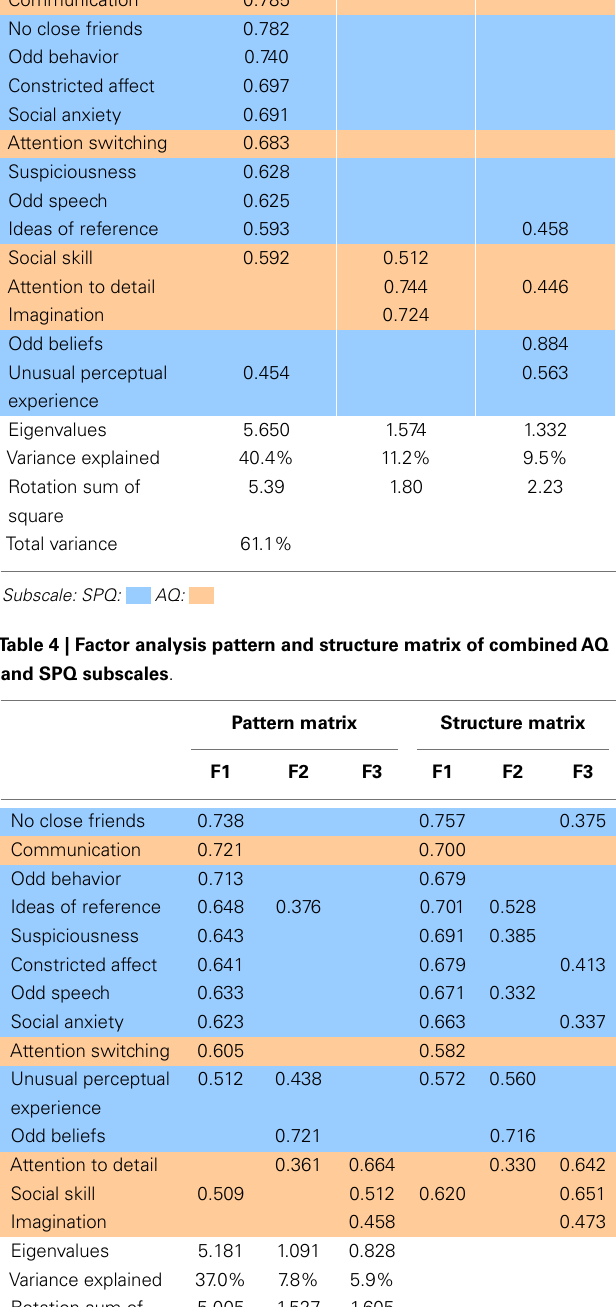
FIGURE 1 | Scatter plot of participant total SPQ vs.AQ scores: weightings of each participant’s three-factor model scores is indicated by an RGB color model (scaled for each factor), where red represents Factor 1, blue represents Factor 2, and green represents Factor 3 (with the same scaling of factor values to color values for each factor). Thus, the low scores in both AQ and SPQ toward the origin tend to be shaded gray, while the extreme AQ and SPQ scores are more